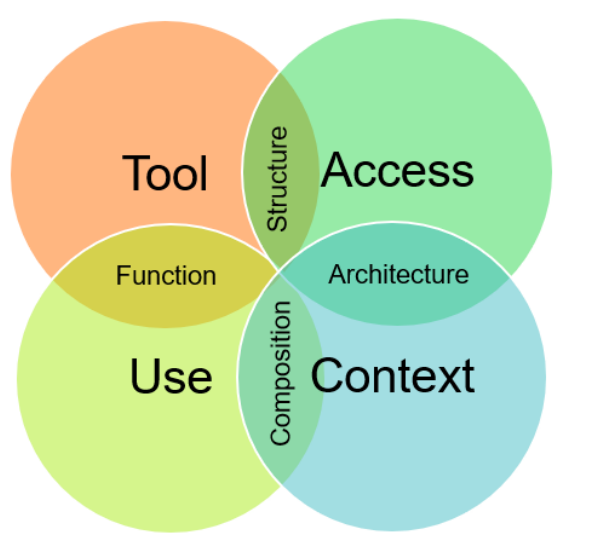
Figure 6. Notions of